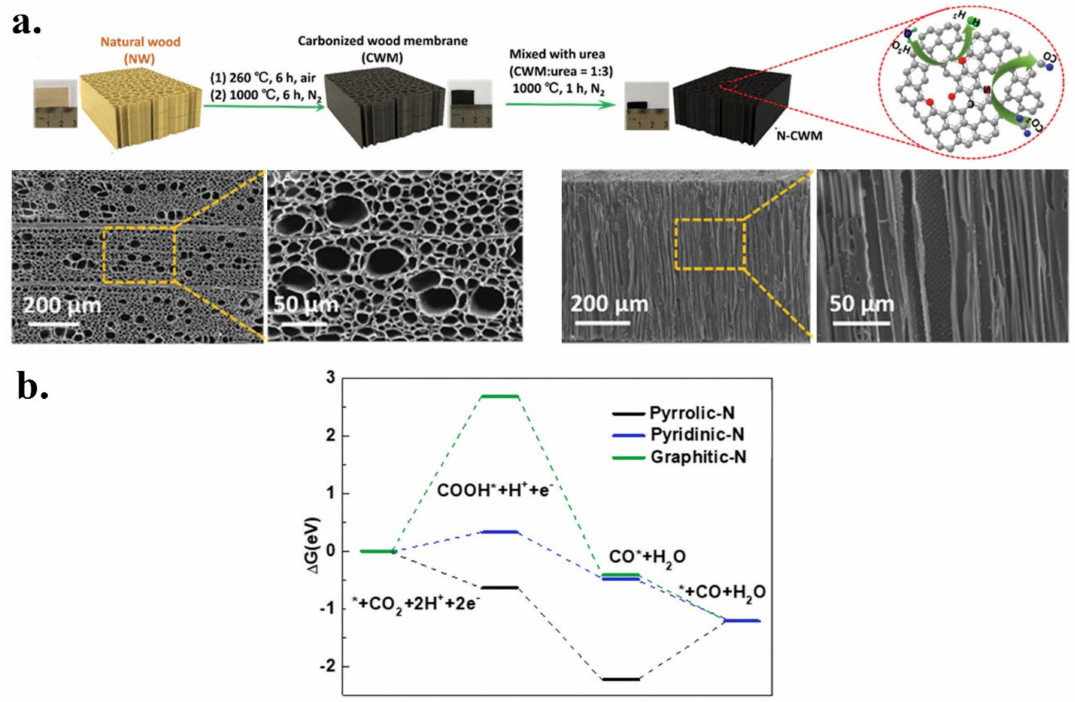
Figure 3. ( a ) Scheme of the synthesis of N-doped carbon membrane from natural wood and top-view and side-view SEM images. ( b ) Calculated Gibb free energy for CO 2 electroreduction to CO on different Nitrogen surface groups of N-doped carbon membrane. Adapted from